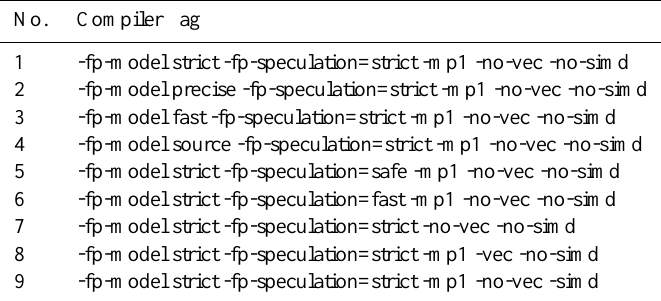
Table 6. Intel compiler flags that are based on the compiler optimization options given in Table 3. The first compiler flag is the strictest one (which limits compiler optimizations most significantly), while every other compiler flag is derived from the first one through changing only one compiler optimization